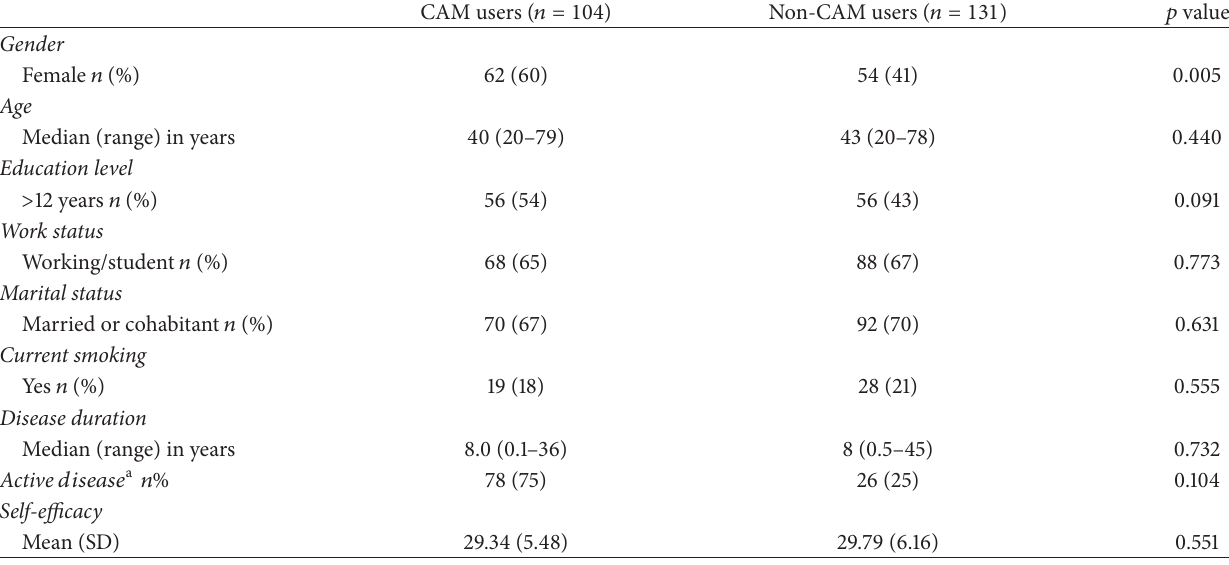
Table 3: Differences in sociodemographic, disease related, and self-efficacy variables between CAM users and non-CAM users ( 𝑁 = 235 ).